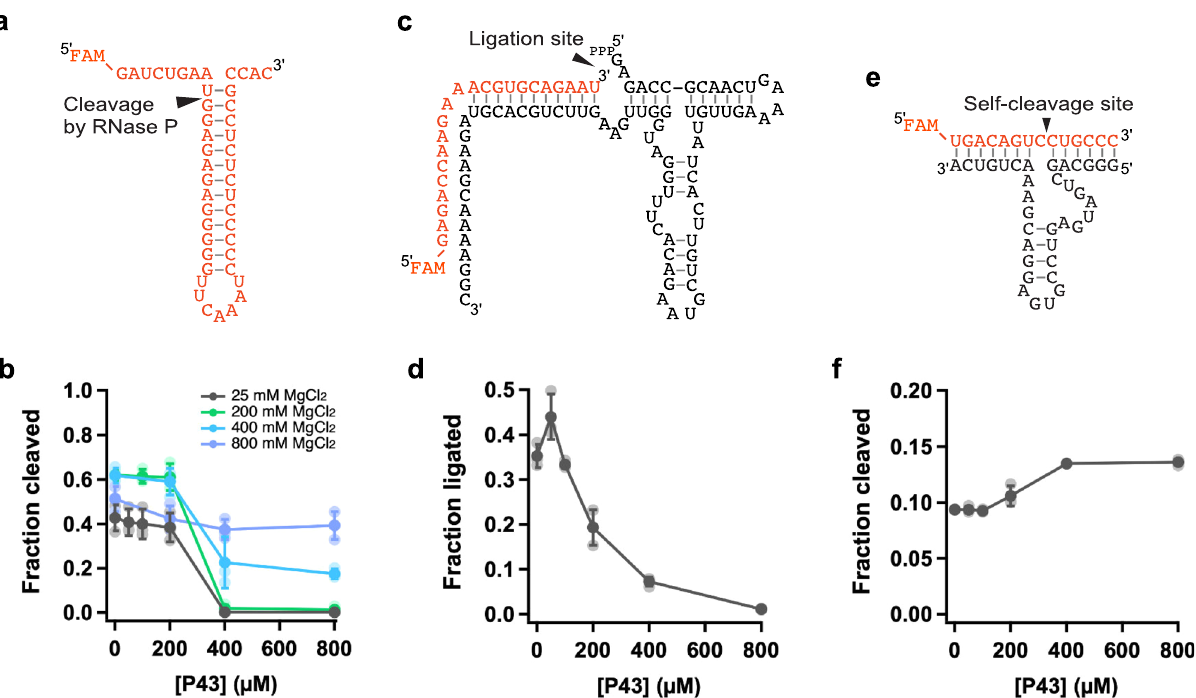
Fig. 6 Activities of various ribozymes in the presence of P43. a Schematic depiction of the substrate for the RNase P ribozyme (pATSerUG). b The substrate cleavage reaction by RNase P in the presence of P43 and different MgCl 2 concentrations. The reactions were incubated in 50 mM Tris • HCl (pH 8.0) buffer containing 25 mM MgCl 2 at 37 °C for 10 min, or in 50 mM Tris • HCl (pH 8.0) buffer containing 200 – 800 mM MgCl 2 and 0.4% DMSO at 37 °C for 2.5 min. c Schematic depiction of F1* ligase. d The self-ligation reaction by F1* ligase was performed in 50 mM Tris • HCl (pH 8.3), 25 mM MgCl 2 , 0.4% DMSO at 25 °C for 20 s. e Schematic depiction of the trans-cleaving hammerhead ribozyme. f The substrate cleavage reaction by the hammerhead ribozyme in 50 mM Tris • HCl (pH 8.3), 25 mM MgCl 2 , 0.4% DMSO. The reactions were incubated at 25 °C for 20 s. b , d , f Data are presented as mean values ± S.D. ( N =